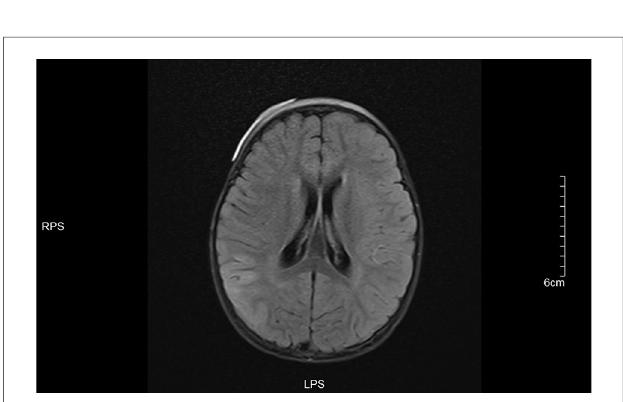
FIGURE 5 Left frontotemporal lobe and right temporo-occipital lobe T1 in Dark- fl uid sequence slightly swollen left frontotemporal lobe and right temporo- occipital lobe gyri with increased signals.